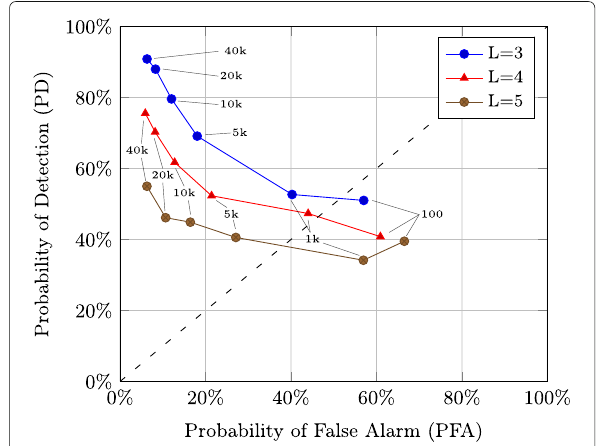
Fig. 12 ROC curve (PFA vs. PD) representing the results from simulations of Morwilog. Each point is the average of the result of 50 simulations with the parameters in Table 2. The size of the dataset is indicated next to the points. L is the length of injected sequences